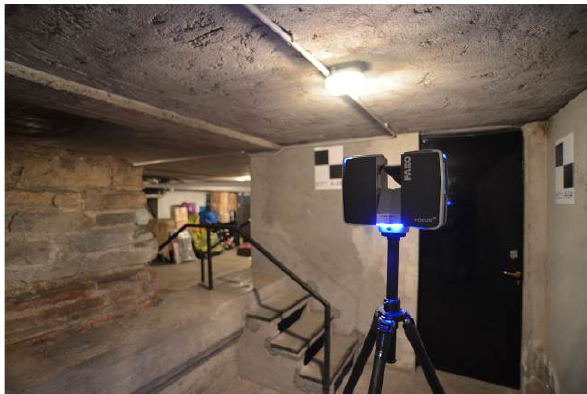
Figure 5. The scanning activities in via San Vito